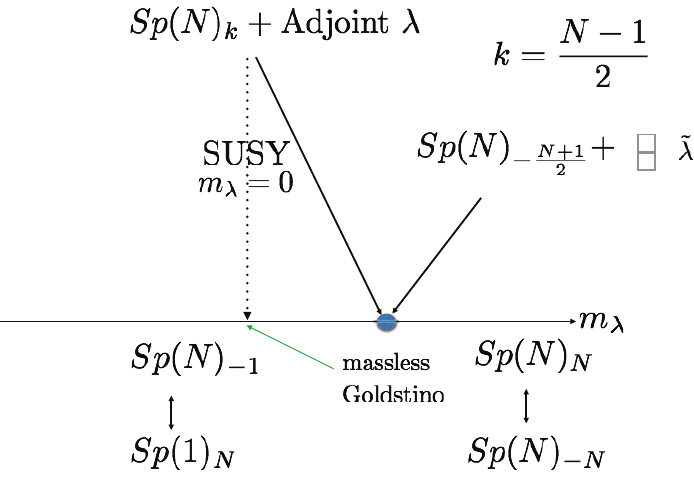
Figure 14: The phase diagram of Sp ( N ) gauge theory with an adjoint fermion and k − 1 Chern-Simons level k = N . There is one transition that connects two nontrivial 2 TQFTs. In addition at one point the Goldstino becomes massless. We propose a fermionic dual for the nontrivial